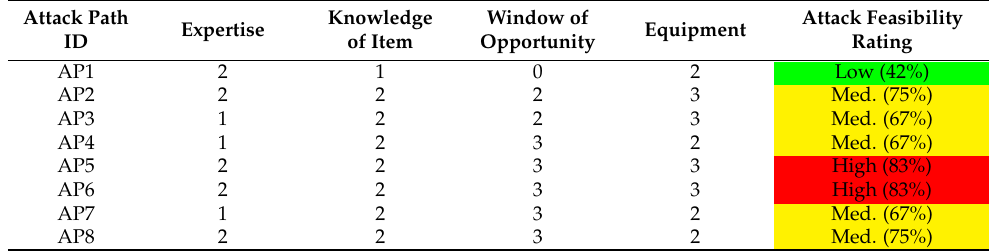
Table 5. AFR for attack paths of the damage scenario “Incorrect Link and Joint Position Communi-